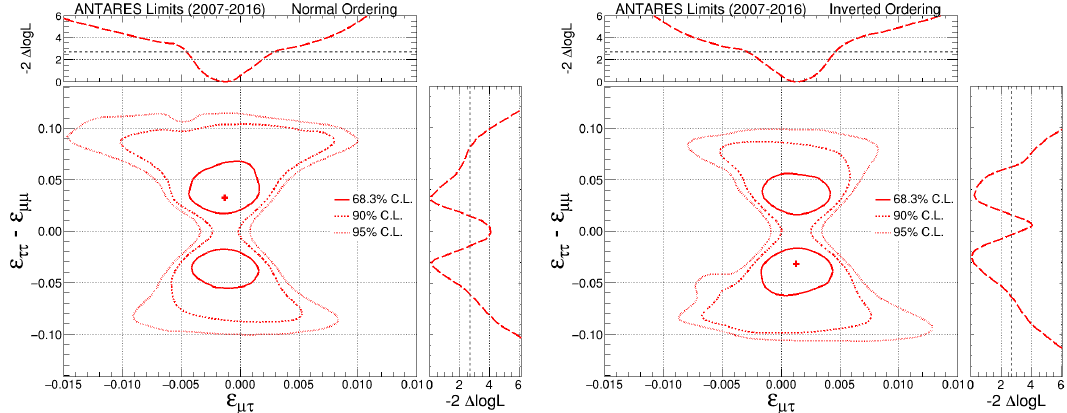
Figure 4 . Contours of 68.3% (solid), 90% (dashed) and 95% (dotted) confidence level on the ( ε µτ , ε ττ − ε µµ ) plane, after 10 years of ANTARES livetime for the NO (left) and the IO (right) cases. The cross indicates the best-fit point obtained in both cases. The lateral plots on both panels show the 1D profile likelihood of the respective NSI parameters under study, when the other parameter is fitted over. The dashed straight lines in the lateral plots indicate the 90% C.L. for one